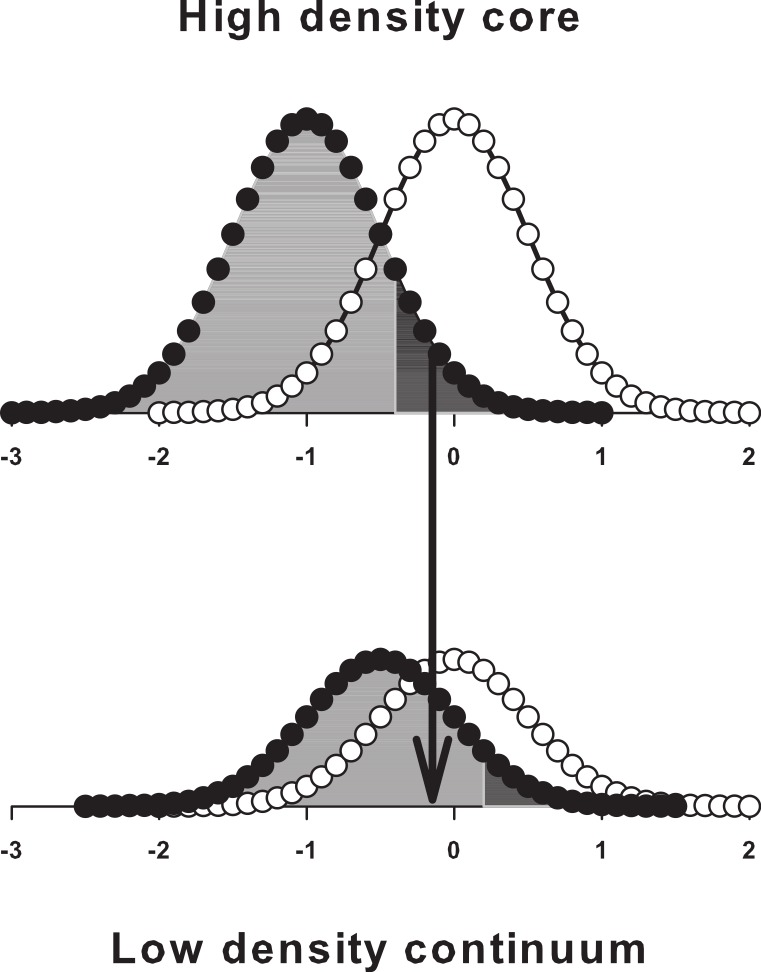
Schematic representation of hypothesized male behaviour in a high density core population immersed in a low density continuum.Models (B) and (D) in Fig. 1 predict that a truncated male emergence curve should evolve in response to frequency-dependent selection and that protandry should be more pronounced in high density populations. In heterogeneous landscapes, late emerging core males could therefore improve their fitness by emigrating to low density areas; selection for such behaviour could prevent the evolution of a truncated emergence curve. Filled and open circles show male and female emergence curves; grey and black shading represent adaptive and maladaptive male emergence timing in isolated populations, with the predicted truncation date lying at the boundary between them; the arrow shows the fitness benefit gained by late emerging core males in dispersing to the continuum; abscissa, arbitrary emergence date; ordinate, relative density emerging.